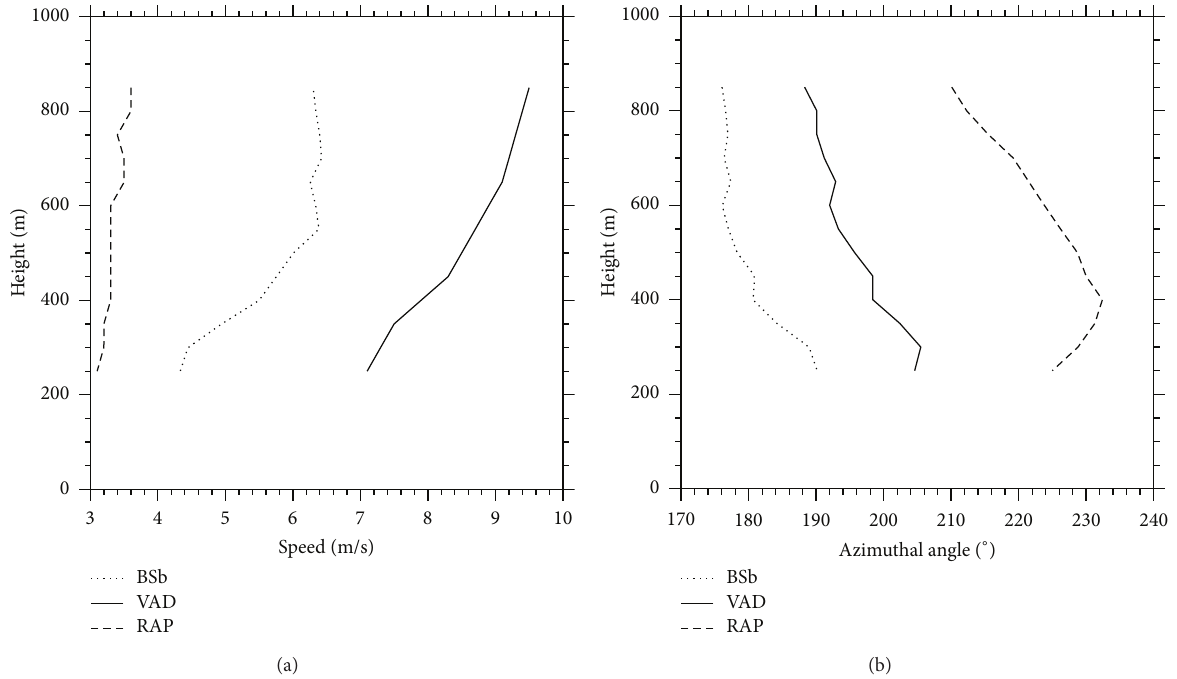
Figure 8: Vertical profiles of (a) absolute value (ms −1 ) and (b) azimuthal angle (clockwise from the north) for two types of horizontal velocities: (i) the horizontal velocity of air plus birds (plotted by the solid profiles) produced by the VAD analysis from the KICT-scanned volumetric velocity data at 090142 UTC but within the 150km radial range to cover BSb pixels only and (ii) the horizontal velocity of air (plotted by the dashed profiles) interpolated from RAP hourly wind analyses to the KICT radar location at 090142 UTC on 30 September 2012. The absolute value and azimuthal angle of the vector difference of the above two velocities (the first minus the second velocity) are plotted by the dotted vertical profiles in panels (a) and (b),